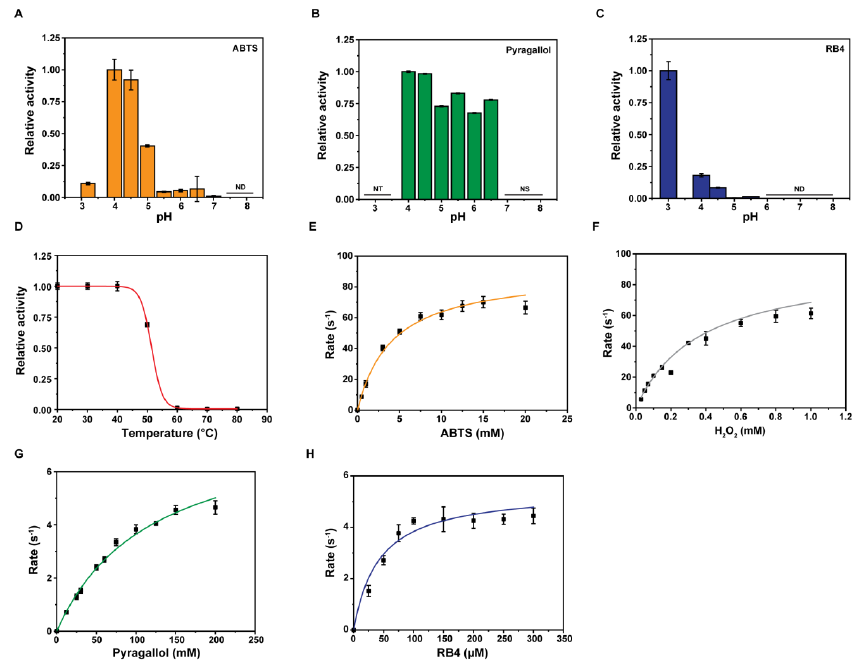
Figure 4. Steady-state kinetic data for Dictyostelium DyPA with different substrates. ( A – C ) Effect of pH on the activity of Dictyostelium DyPA. Optimum pH of Dictyostelium DyPA toward oxidation of ATBS, pyrogallol, and RB4. ( D ) Thermal stability of Dictyostelium DyPA. ND, not detected; NT, not tested, and NS, not stable (substrate was not stable at this pH). ( E – H ) Steady-state kinetic data for Dictyostelium DyPA with varying substrate concentration. The observed rates were plotted against the substrate concentrations and fitted to the Michaelis – Menten equation, and parameters are summarized in Table 2. ( E ) ABTS, ( F ) H 2 O 2 *, ( G ) Pyrogallol, and ( H ) RB4. * 15 mM ABTS was used as a substrate for H 2 O 2 measurements. Data are average values of 3 – 6 independent measurements, and bars represent the standard deviations. Table 2. Steady-state kinetic data for Dictyostelium DyPA.